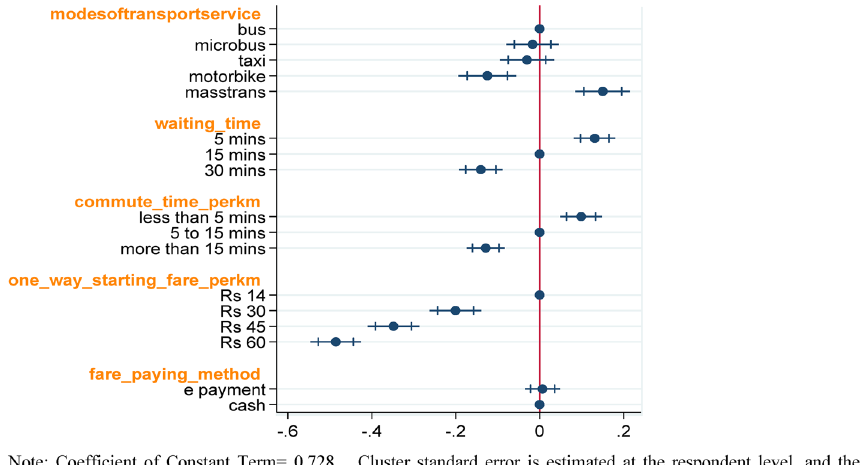
Fig. 4 Average causal effect on the internal choice probability. Coefficient of Constant Term Cluster standard error is estimated at the respondent level, and the horizontal bar is adjusted within a 95% confidence interval. Rs represents Nepalese